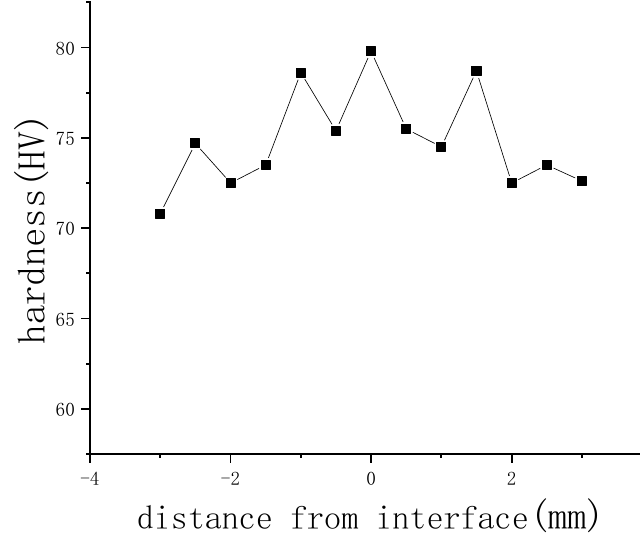
Figure 15. Interface hardness distribution.